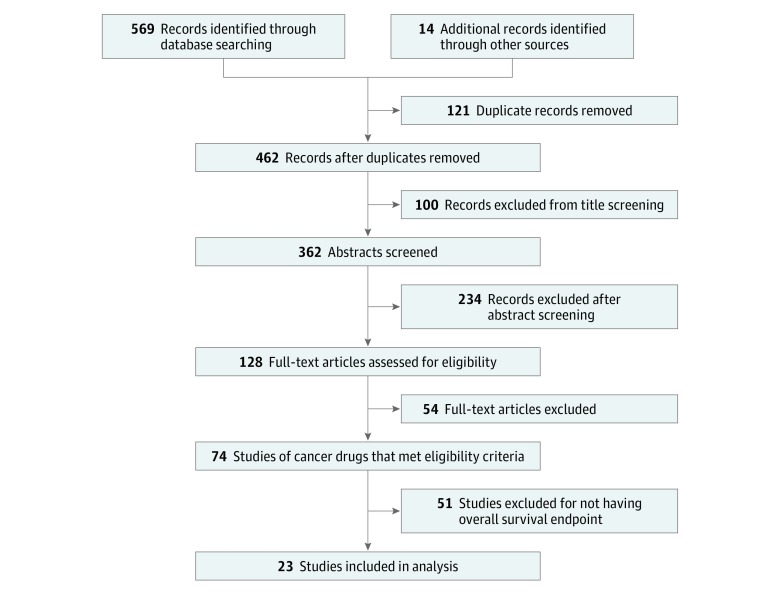
Flow Diagram for the Selection of Studies